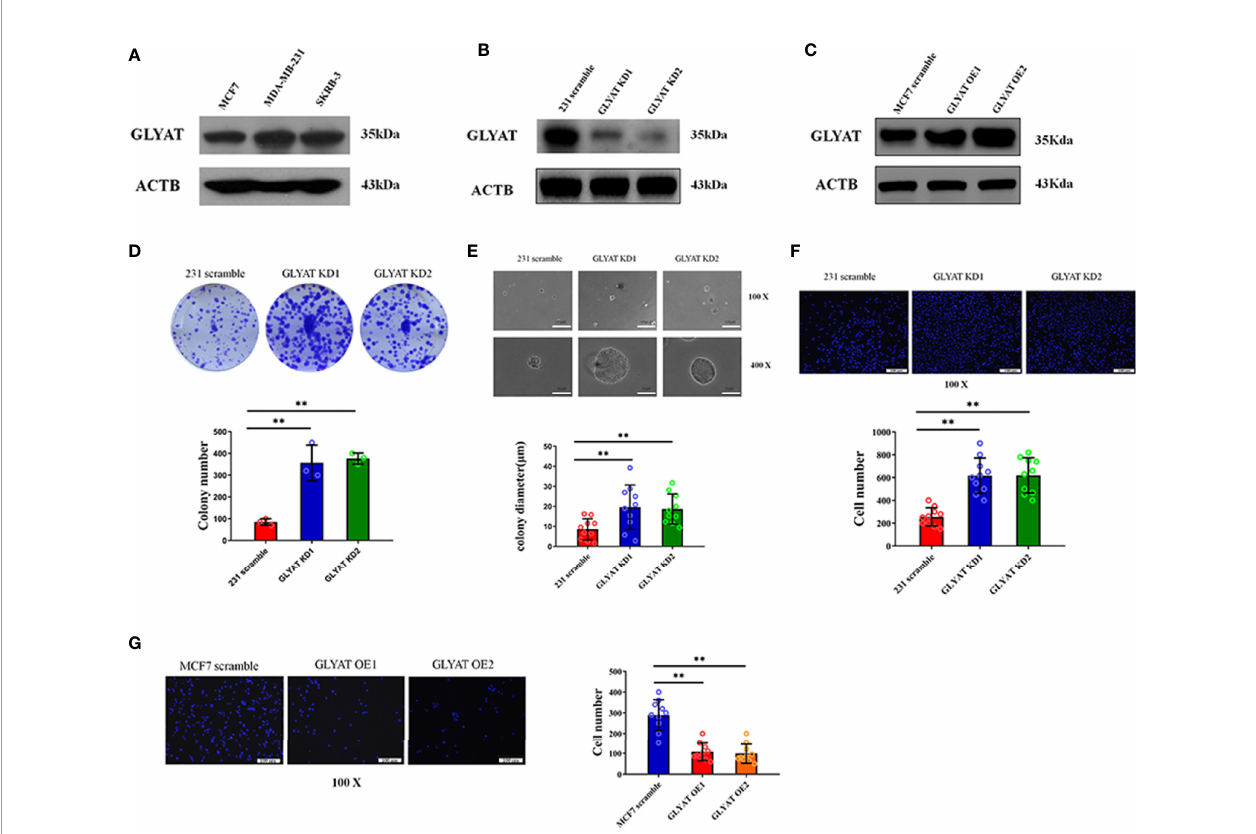
FIGURE 2 | GLYAT suppresses BC cell proliferation and metastasis. (A) GLYAT protein level was assessed in different BC cell lines. (B) MDA-MB-231 cells were transfected with the GLYAT KD plasmid and a scrambled plasmid as control. The suppression of GLYAT in MDA-MB-231 cells was con fi rmed at the protein level. (C) MCF-7 cells were transfected with the GLYAT OE plasmid and a scrambled plasmid as control. The overexpression of GLYAT in MCF-7 cells was con fi rmed at the protein level. (D, E) GLYAT KD in MDA-MB-231 cells signi fi cantly increased colony numbers and size compared with the scramble cells. (F) The Transwell assay revealed that the migration ability of MDA-MB-231 cells was signi fi cantly increased following transfection with GLYAT KD1 and KD2 compared with the scramble control. (G) The Transwell assay revealed that the migratory ability was signi fi cantly decreased in GLYAT OE MCF-7 cells compared with scramble control. ** p < 0.01. Scale bars for (E) are 100 m m and 25 m m, and for (F, G) are 100 m